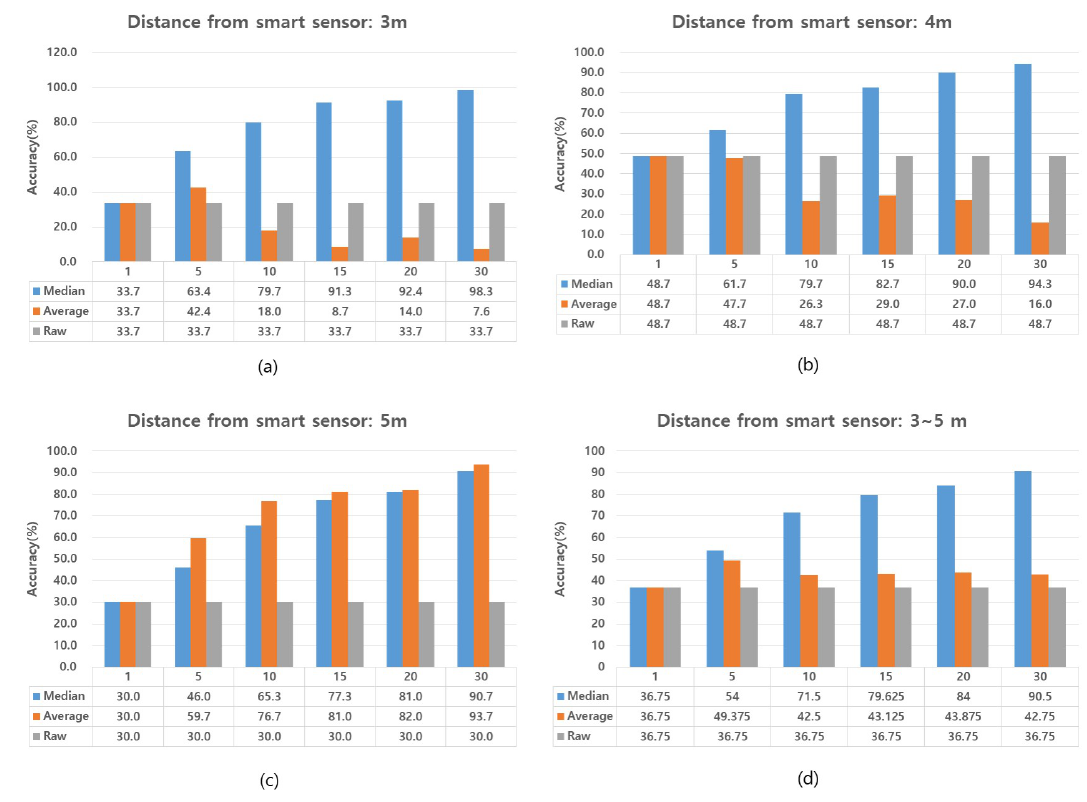
Figure 12. Accuracy of proximity calculations. The interval between smart sensor and beacon is ( a ) 3 m, ( b ) 4 m, ( c ) 5 m, ( d ) 3–5